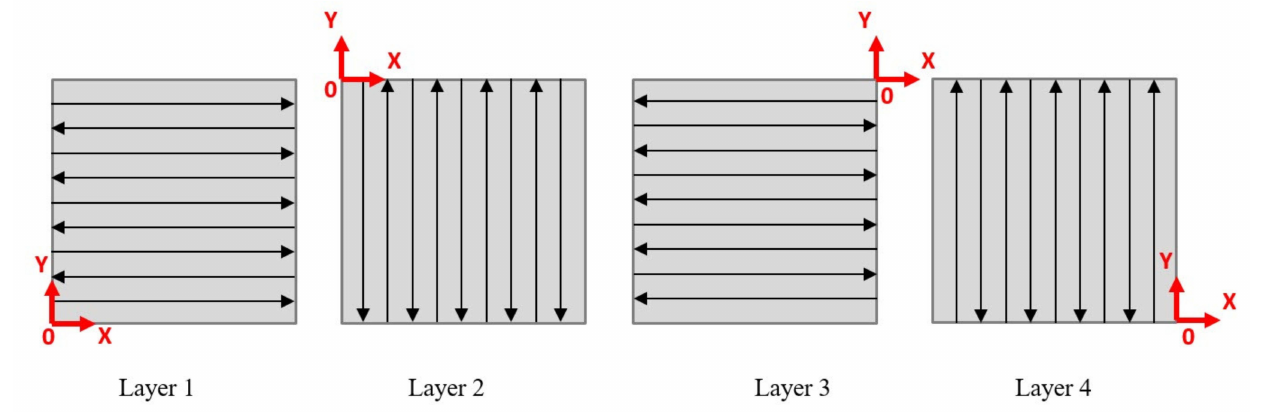
Figure 4. Multi-layer model.